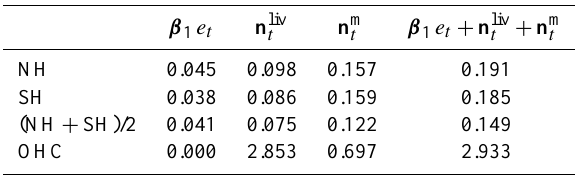
Table A4. Estimates of standard deviations of β 1 e t , n liv t , and n m t , and the sum of these three terms.